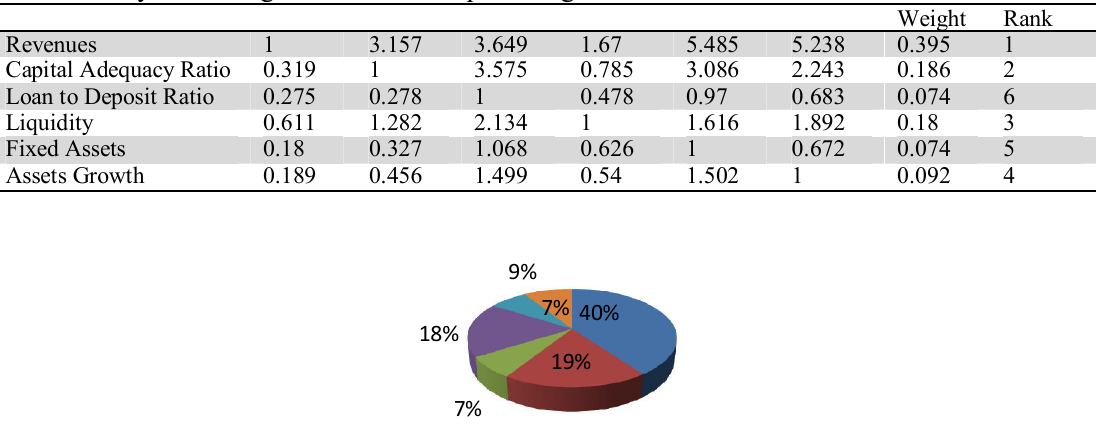
The summary of ranking each factor for optimizing bank balance sheet